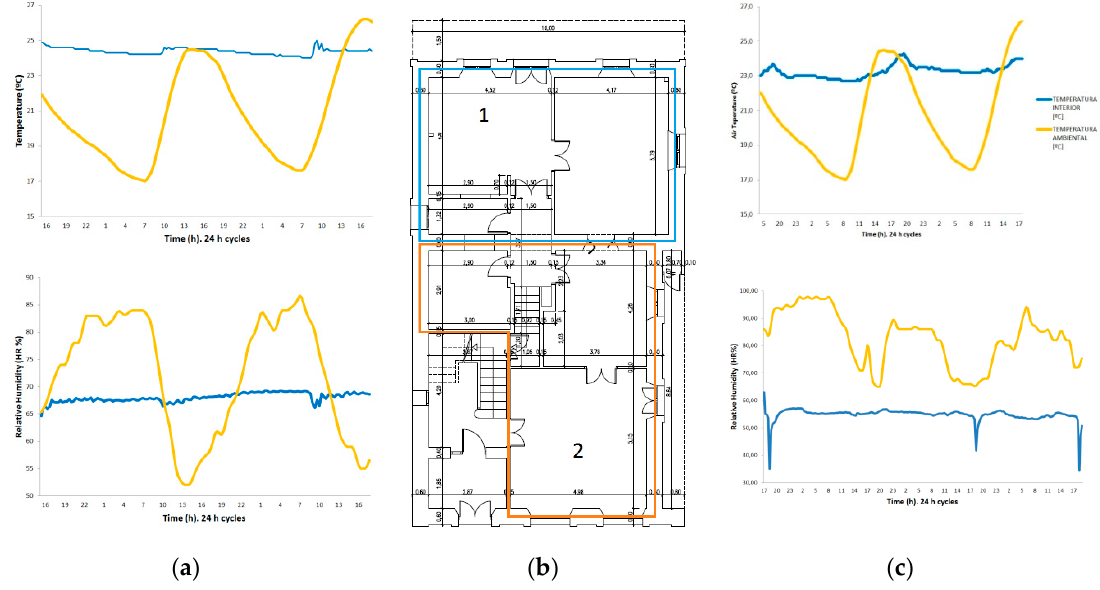
Figure 2. ( b ) Sections 1 and 2 on the ground floor. T Indoor /RH Indoor (blue line) and T Outdoor /RH Outdoor (yellow line) evolution: ( a ) from 23 to 25 August 2016 at Section 1 ( c ) from 29 to 31 August 2016, at Section 2